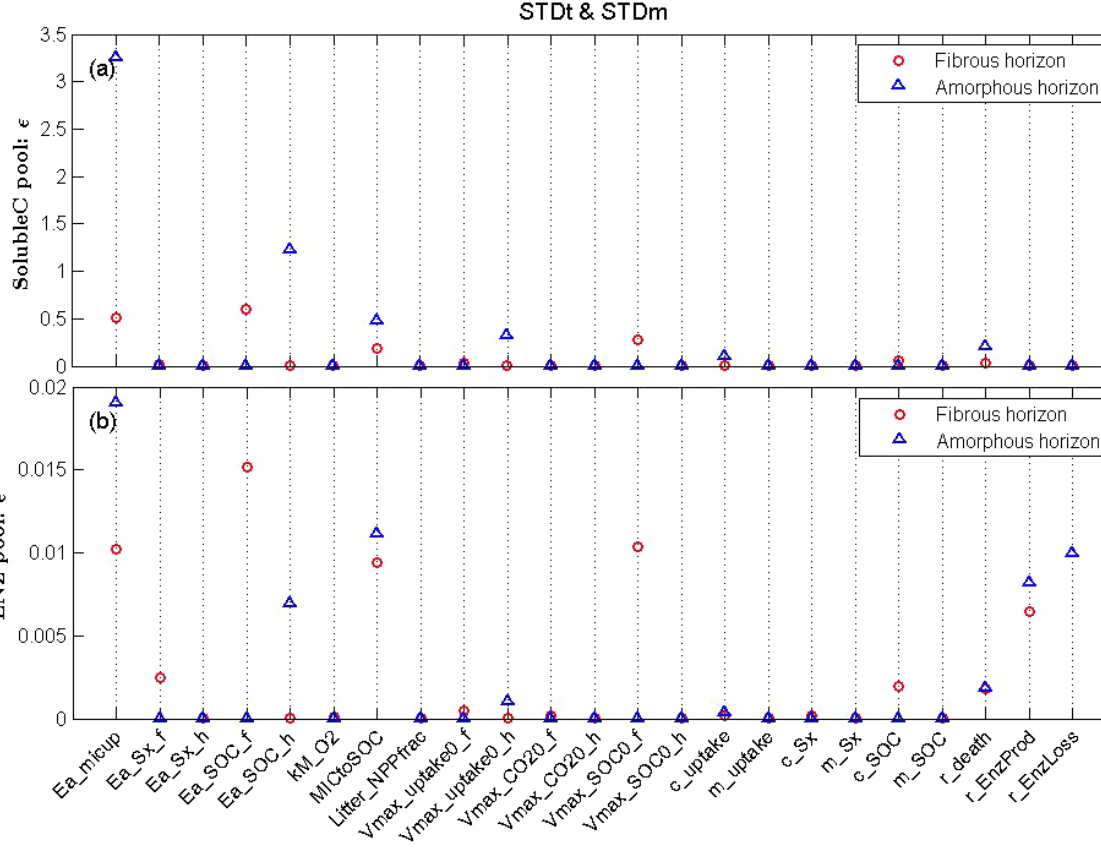
Figure 5. Screening test results (sensitivity index ε = standard soil temperature and moisture (STDt and STDm)